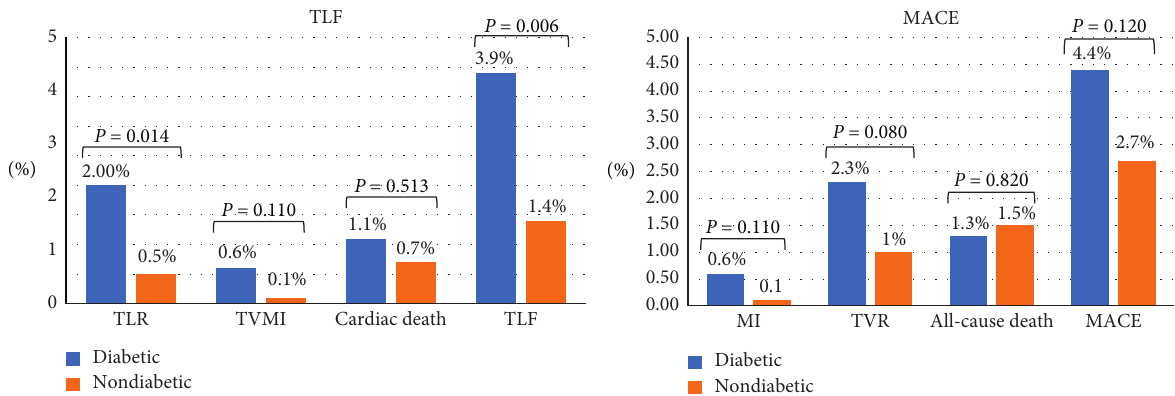
Figure 2: Study endpoints at 12 months. MACE: major adverse cardiac events; MI: myocardial infarction; TLF: target lesion failure; TLR: target lesion revascularization; TVMI: target vessel myocardial infarction; TVR: target vessel